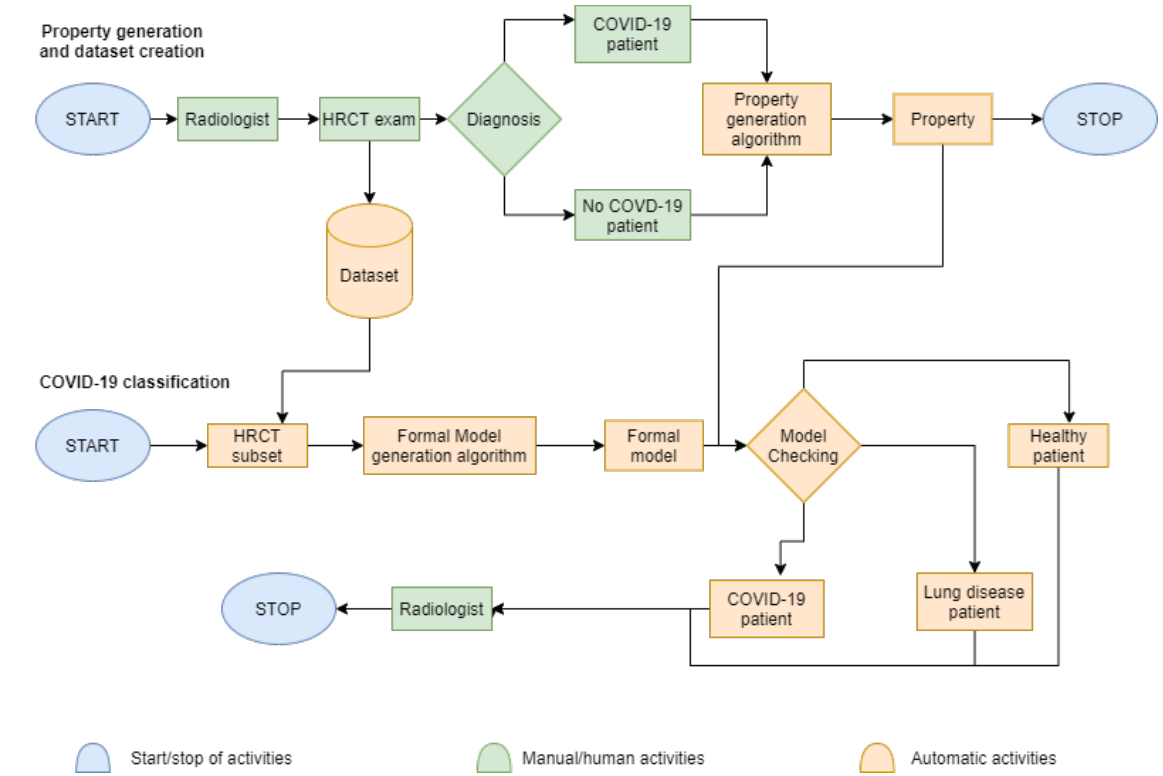
Figure 2. The method is above described as a block diagram divided in two processes. The first process represents the standard way a patient have to pass to do a HRCT exam and get a diagnosis. The second process, instead, exploits the first process via the complete dataset and the human knowledge of the radiologist to try to replicate the correct